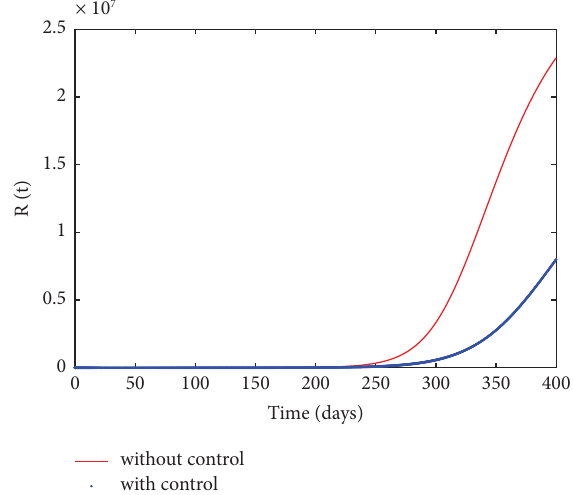
Figure 21: Behaviour of the recovered individuals with and without the vaccination